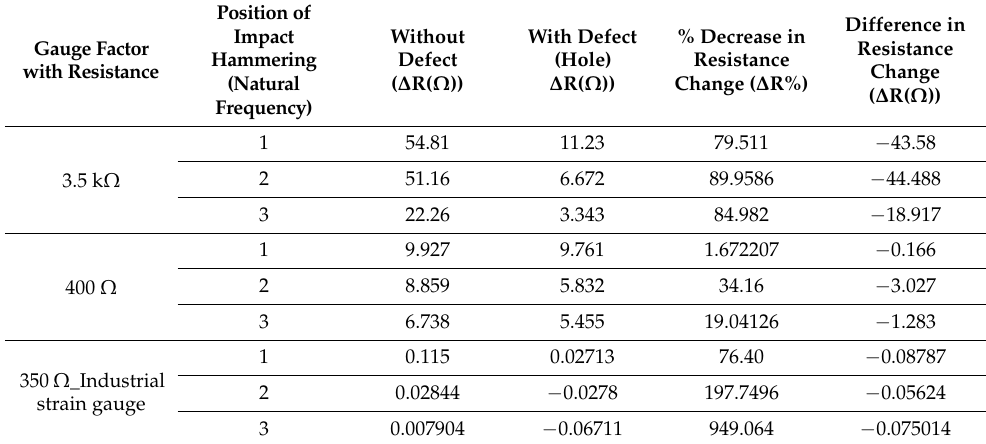
Table 1. Quantitative analysis of electrical resistance during impact hammering at different